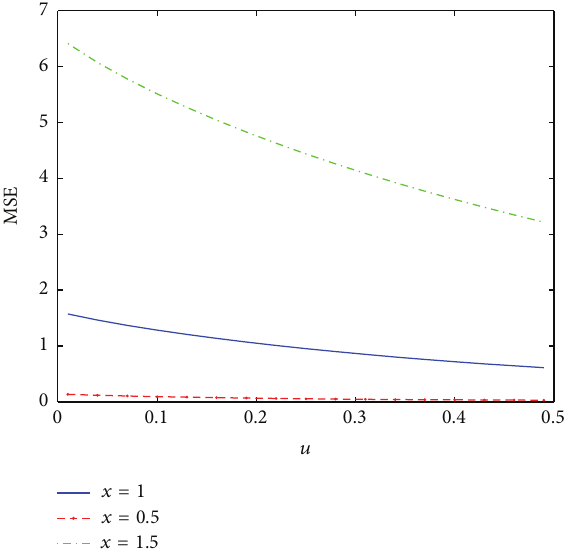
Figure 6: MSE of (17) at 𝑥 = 0.5 , 𝑥 = 1 , and 𝑥 = 1.5 .